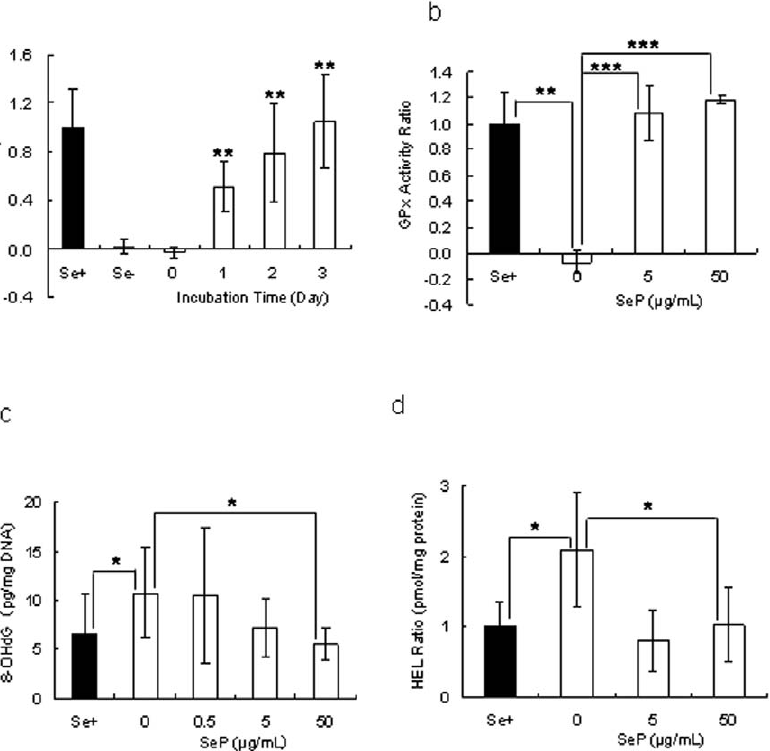
Figure 4. SeP addition suppresses oxidative stress in selenium-deficient CEPI cells. a: Recovery of GPx activity by addition of SeP. Fifty m g/ mL SeP was added to culture medium and incubated for 0, 1, 2, or 3 days. ** indicates a significant difference from the result in Se-, P , 0.01 (n=8). b: Recovery of GPx activity by addition of SeP (5 or 50 m g /mL) and incubated for 3 days. ** P , 0.01 and *** P , 0.005, respectively (n=6). c, d: Suppression of production of 8-OHdG. (c, n=8) and HEL (d, n=5) in CEPI cells. SeP (0.5, 5 or 50 m g /mL) was added to medium and cells were incubated for 3 days. * P , 0.05. All results are expressed as mean 6 S.D. Dunnett’s test was used to determine the significance of differences. Se + : GPx activity of CEPI cells cultivated in normal medium. Se-: GPx activity of CEPI cells cultivated in selenium-depleted